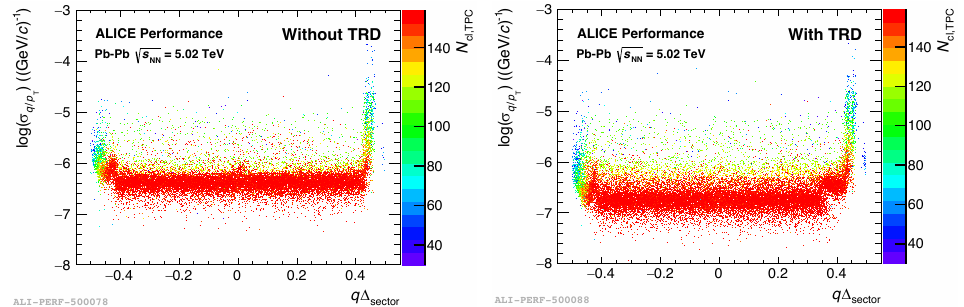
Figure 2. The relative improvement depends on the interaction rate. For data collected at a